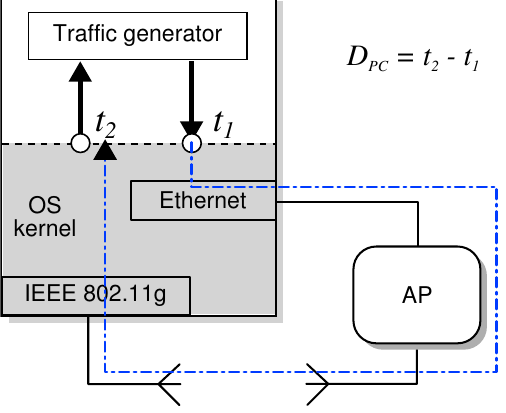
Figure 2. The setup adopted for emulating a simple hybrid industrial